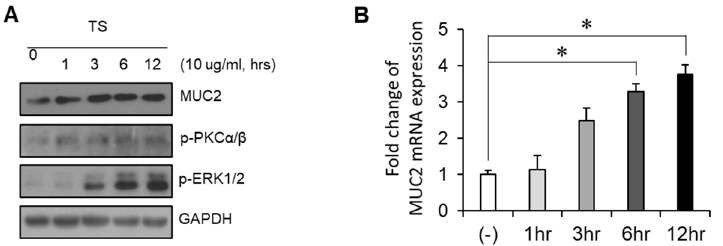
Figure 3. Identification of the signaling pathway involved in trifostigmanoside I-induced MUC2 expression. ( A ) LS174T cells were treated with trifostigmanoside I at different time points, and the expressions of MUC2, p-PKC α / β , p-ERK1/2, and GAPDH were assessed by Western blotting. ( B ) Semi-quantitative real-time PCR to assess the expression of MUC2 in LS174T cells after treatment with trifostigmanoside I at different time points. Data are presented as mean ± SEM of triplicate assays. All Western blot results were quantified by using Image J. * p < 0.05. TS, trifostigmanoside I.